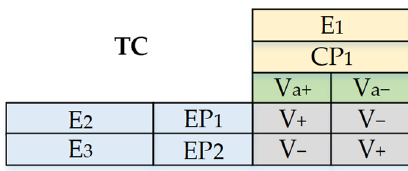
Figure 11. ENV Conflict Model.